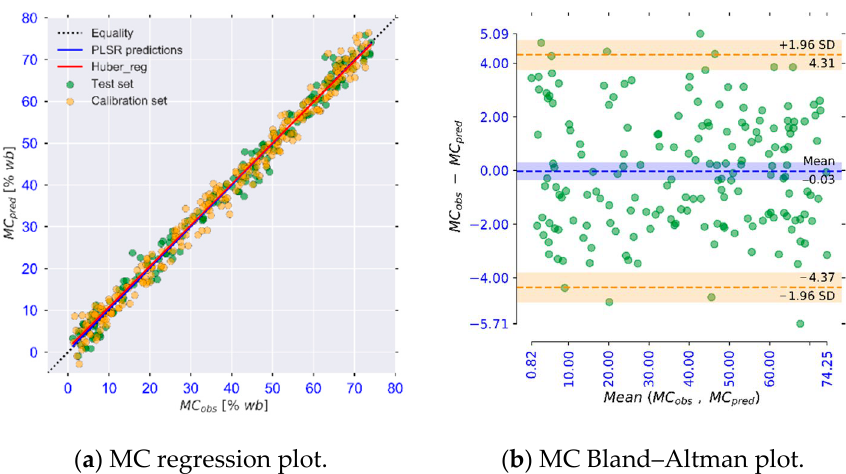
Figure 9. Regression plot and Bland-Altman plot for MC.